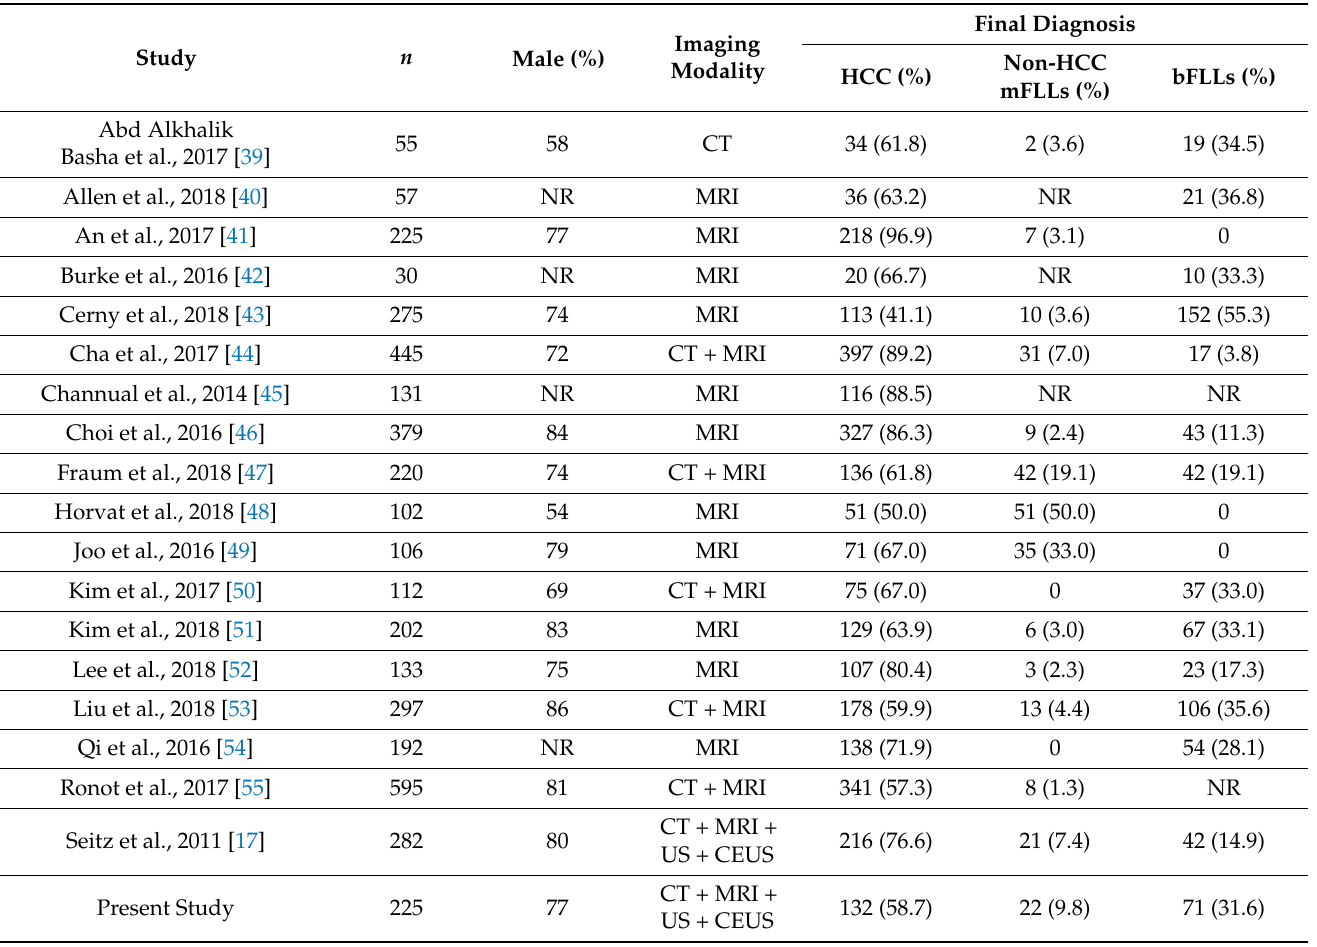
Table 5. A summary of some of the studies on the prevalence of different benign and malignant FLLs in patients with liver